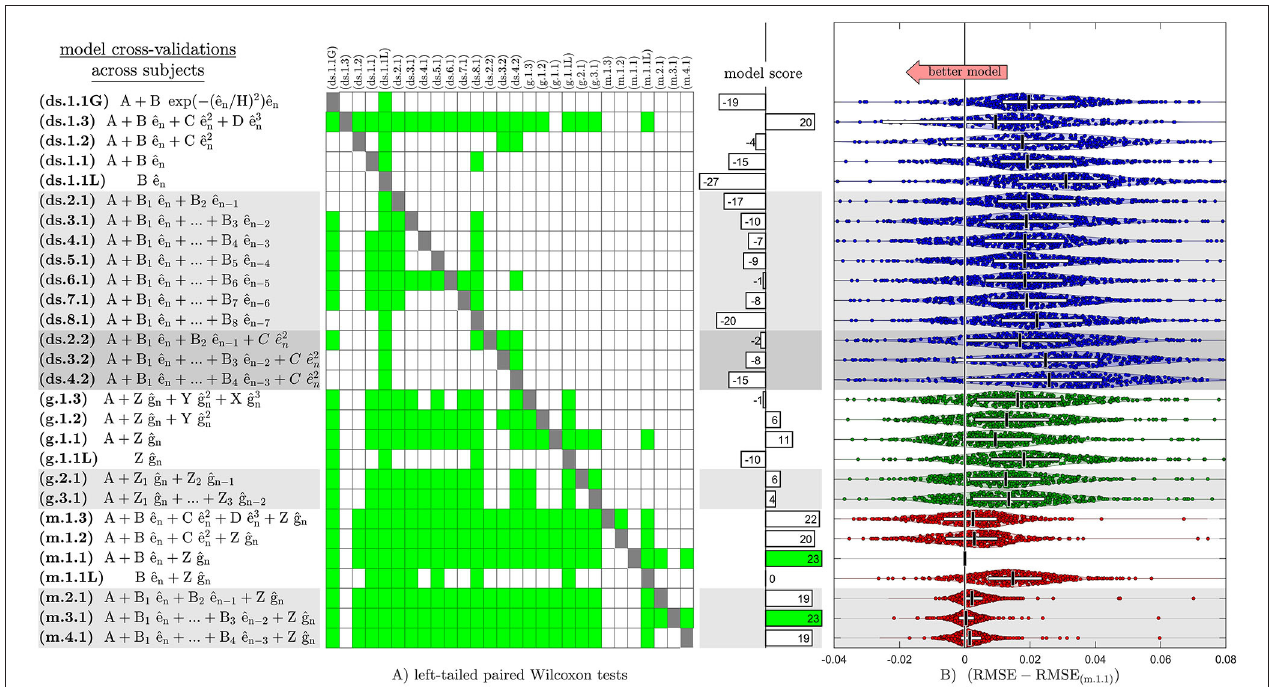
FIGURE 4 | Accuracy between model predictions and observations during the cross-validation across subjects, indicating the superiority of the first-order mixed model (m.1.1). (A) Left-tailed paired Wilcoxon tests are shown on a matrix, where a green square indicates significantly lower RMSE in the cross-validation test set partitions ( p < 0.01; with Bonferroni correction; toward lower RMSE) for the model listed along its row compared to the model listed along its column. No statistical tests were performed along the diagonal of the matrix as indicated by dark gray squares. The histogram next to the matrix shows the model score as the number of times a particular model had significantly lower RMSE compare to other models minus the number of times other models had significantly lower RMSE compare to a particular model (number of green squares across a model’s row number of green squares across a model’s column). (B) Each dot represents a paired difference between its respective model’s and the first-order mixed model’s (m.1.1) MLE of RMSE for a cross-validation test set partition. Horizontal white bars and vertical black bars represent inter-quartile range and median of the paired differences of RMSE across all cross-validation test set partitions. Shaded regions show kernel density estimates for the distribution. The first- and third-order mixed models with constant learning rates (m.1.1 and m.3.1) had significantly lowest RMSE ( p < 0.01) and performed equally best in the cross-validation test set partitions across subjects. The first-order mixed model (m.1.1) was clearly the winner since it had the lowest number of model